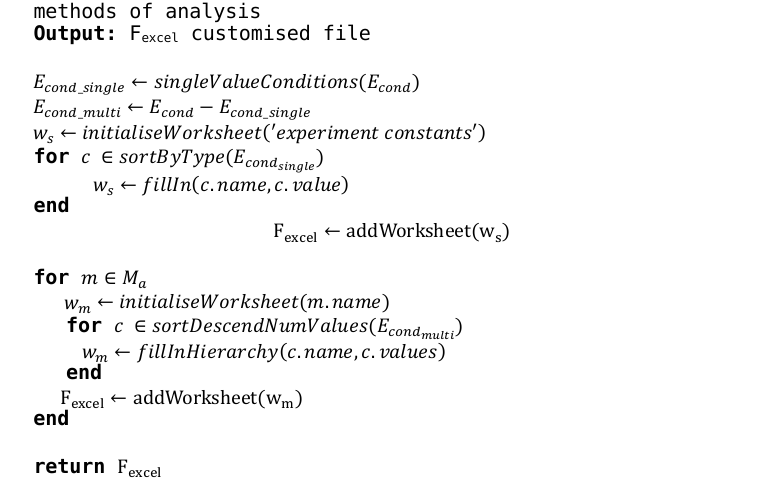
F excel Fig. 2: Pseudo-code of the systematic construction of biofilm structured data